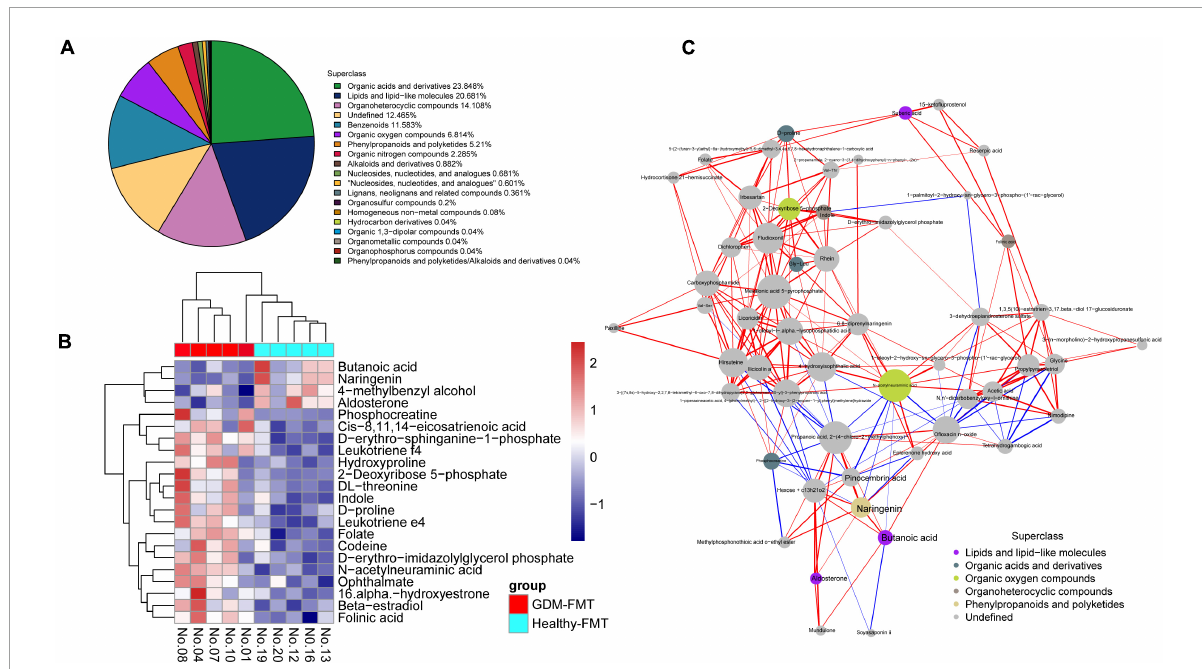
FIGURE3 High-resolution non-target metabolomics report. (A) The proportion of the number of identified metabolites in each chemical classification. The blocks of different colors in the figure express different chemical classification attribution items, and the percentage represents the percentage of the number of metabolites in the chemical classification attribution entry to the number of all identified metabolites. Metabolites without chemical classification are defined as undefined. (B) Significantly different metabolite hierarchical clustering heatmap. Each row represents a differential metabolite, and each column represents a set of samples. Red represents upregulation and blue represents downregulation. Metabolites with similar expression patterns gather under the same cluster on the left. (C) The dots in the figure represent significantly different metabolites. The size of the dot is related to the degree of connectivity. The greater the degree, the larger the dot. The color of the line represents correlation, red represents positive correlation, and blue represents negative correlation. The thickness of the line represents the absolute value of the correlation coefficient. The thicker the line, the greater the